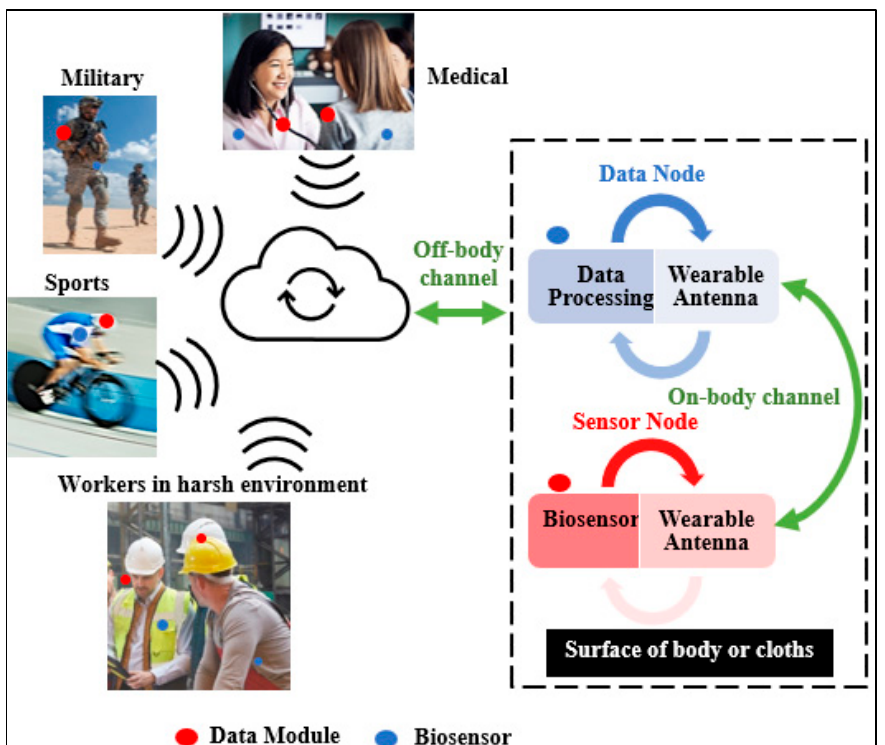
Figure 1. The general architecture of WBAN in healthcare applications.